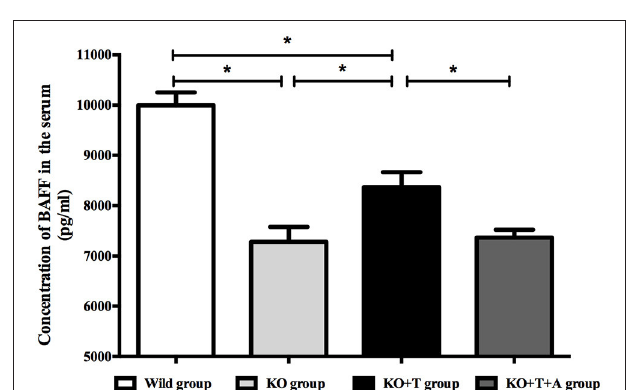
FIGURE 4 | Effect of IL17- γδ T cells on BAFF production. The mice in all groups were processed as described in Figure 2 . Serum BAFF levels on day 7 post infection were measured using ELISA. * p < 0.05. These results represent three independent experiments.